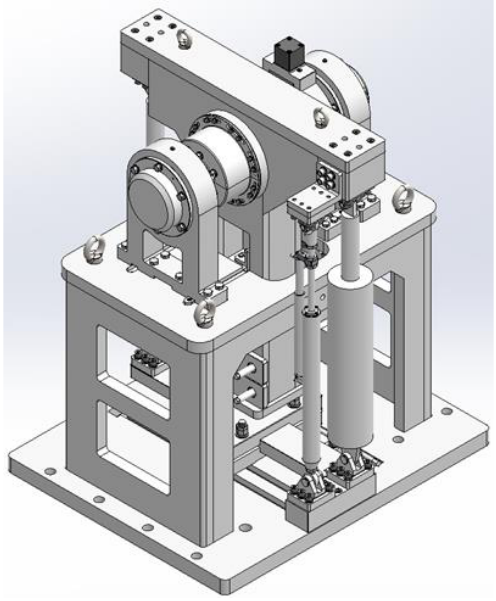
Figure 1. System 3D design drawing.